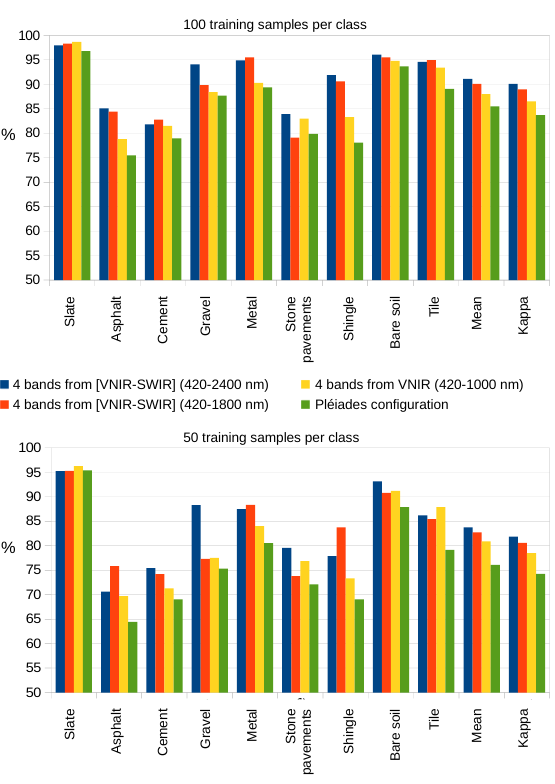
Figure 8: Quantitative evaluation of results reached using se- lected band subsets of 4 bands from different spectral domains: F-scores of the different classes and Kappa coefficient reached by RBF SVM classification. The classifier was trained using 100 samples (top) and 50 samples